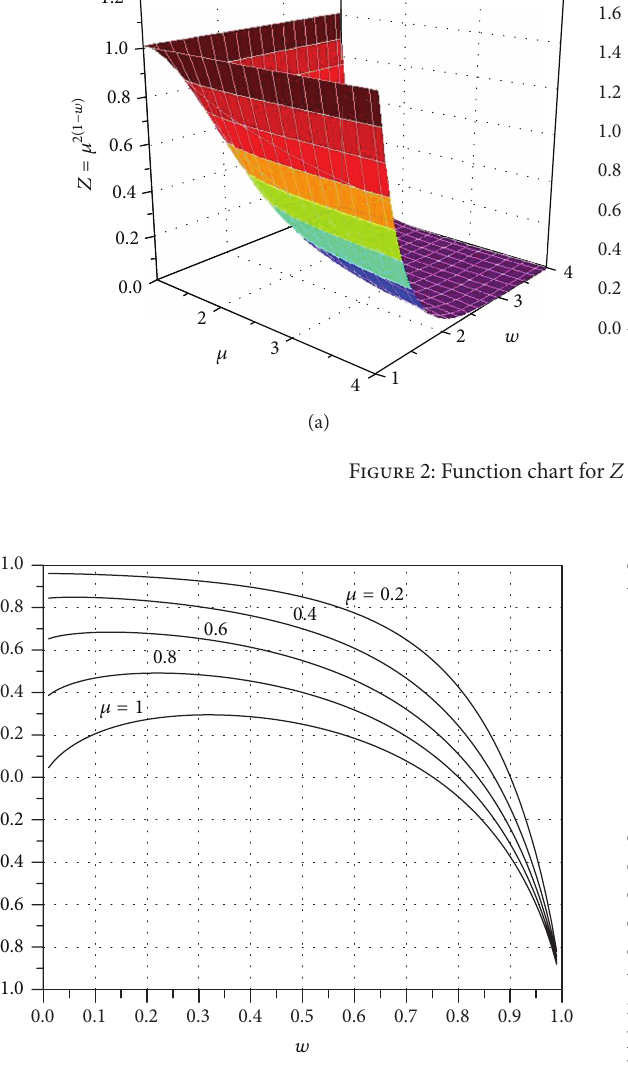
Figure 3: Function chart for 𝑓(𝜇,𝑤) under different 𝜇